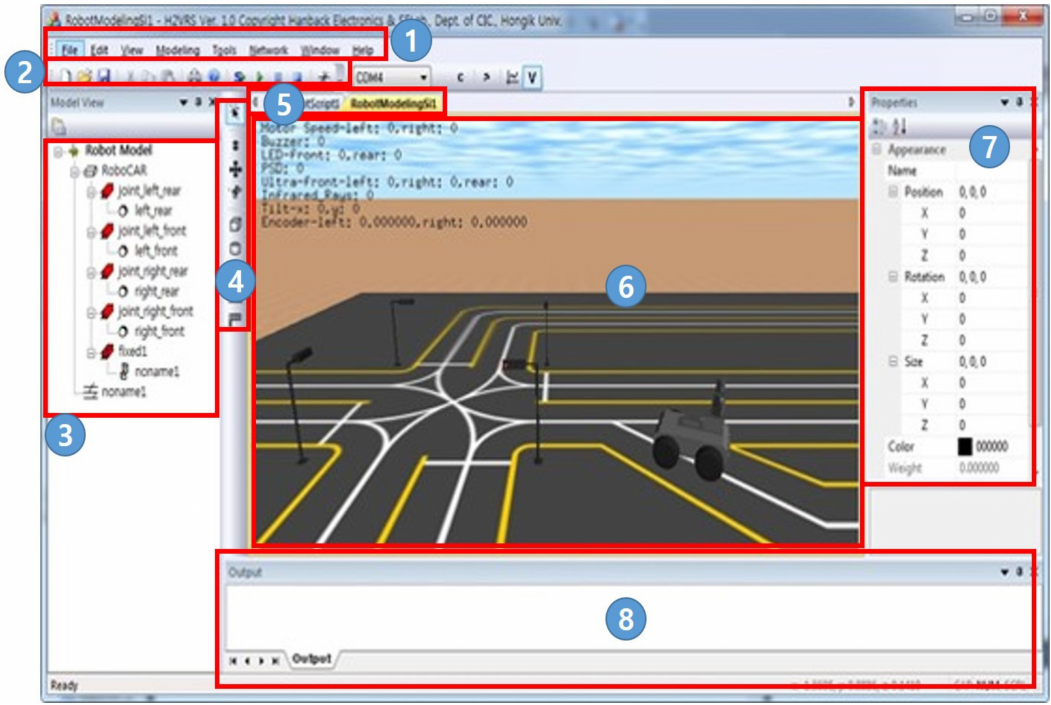
Figure 8. Smart tra ffi c control